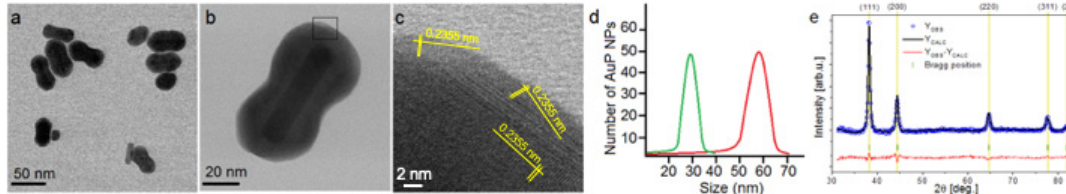
Figure 1. Overview BF STEM ( a , b ); HRSTEM image with indicated lattice distances of Au corresponding to the {111} planes. ( c ), size distribution of longitudinal (red curve) and transverse (green curve) axis ( d ) and XRD ( e ) taken for Au NPes. Experimental (blue dots) and calculated (solid black line) Rietveld refinement plot of the XRD pattern for the Au NPes. The red line (YOBS—YCALC) represents the di ff erence between the observed and calculated data. Tick marks show allowed Bragg reflections (color online).